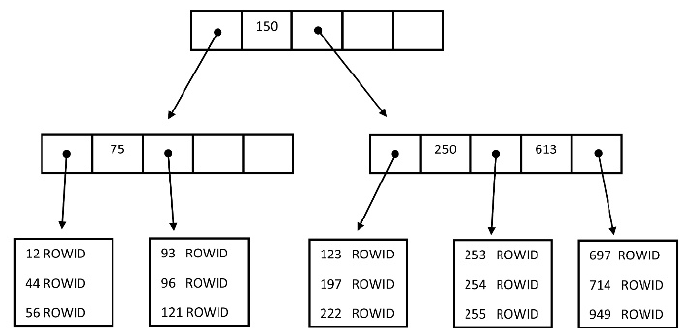
Figure 2. B-tree structure containing ROWID pointers in the leaf layer.